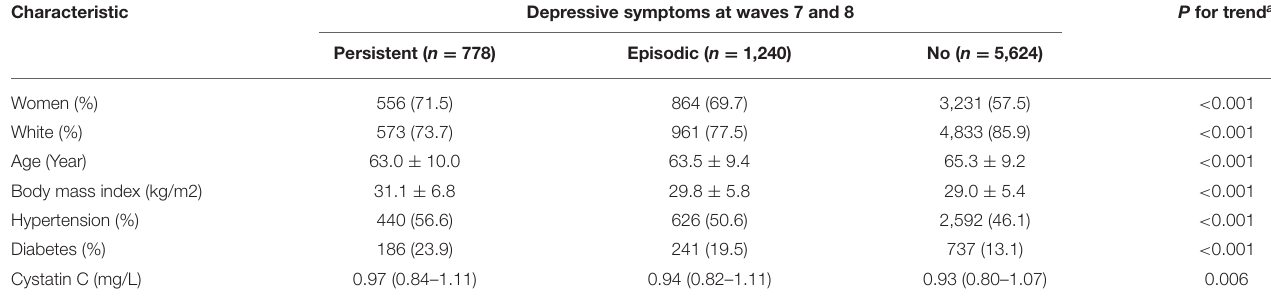
TABLE 1 | Characteristics of the study participants at